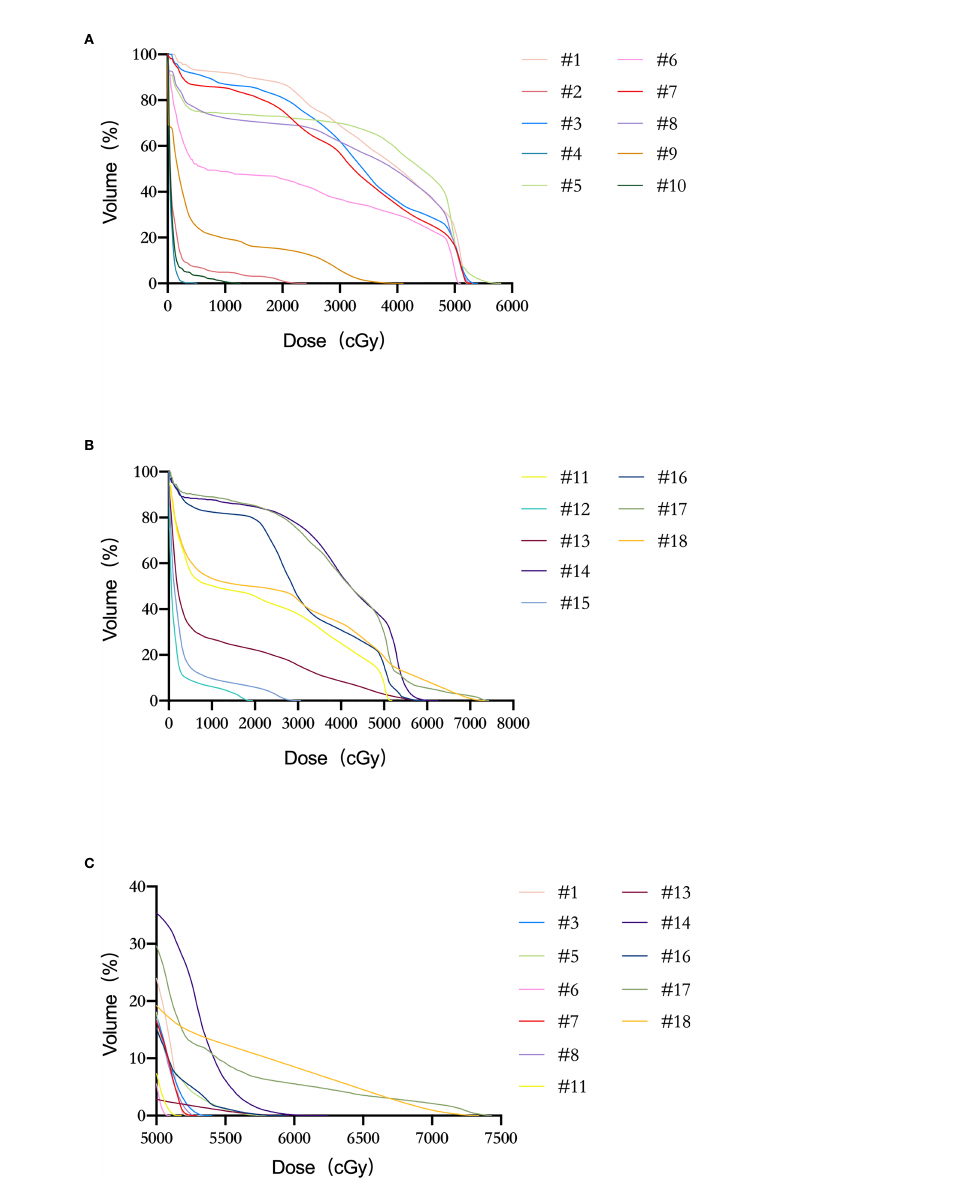
FIGURE 4 Dose – volume histogram (DVH) of LSP nerves for patients #1 – 18. (A) Patients #1 – 10. (B) Patients #11 – 18. (C) Patient with the dose delivered to LSP ≥ 50